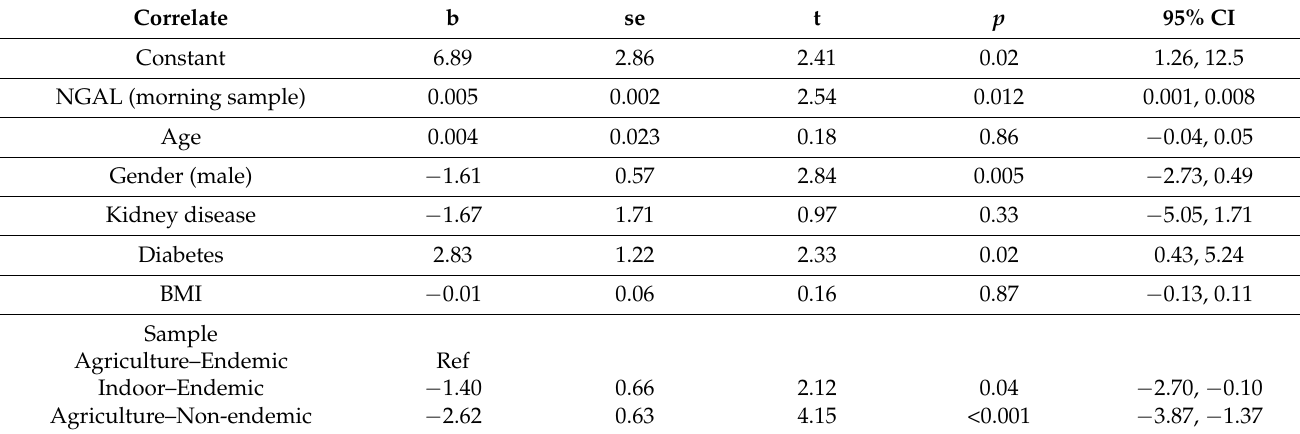
Table 3. Correlates of heat stress: regression model and NGAL